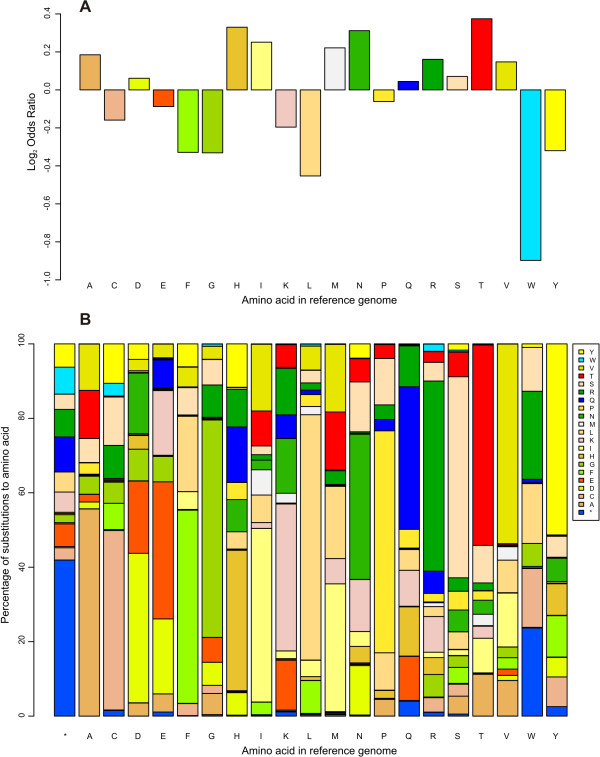
Amino acids in the reference genome affected by SNPs. A. Log2 odds ratio relating the number of non-synonymous substitutions per amino acid with its abundance in the whole non-redundant proteome. All ratios are significantly different from 1 after Benjamini-Hochberg [63], p-value correction (FDR ≤ 5E-2, see Additional file 8). B. Proportion of amino acids affected by SNPs (synonymous and non-synonymous substitutions).